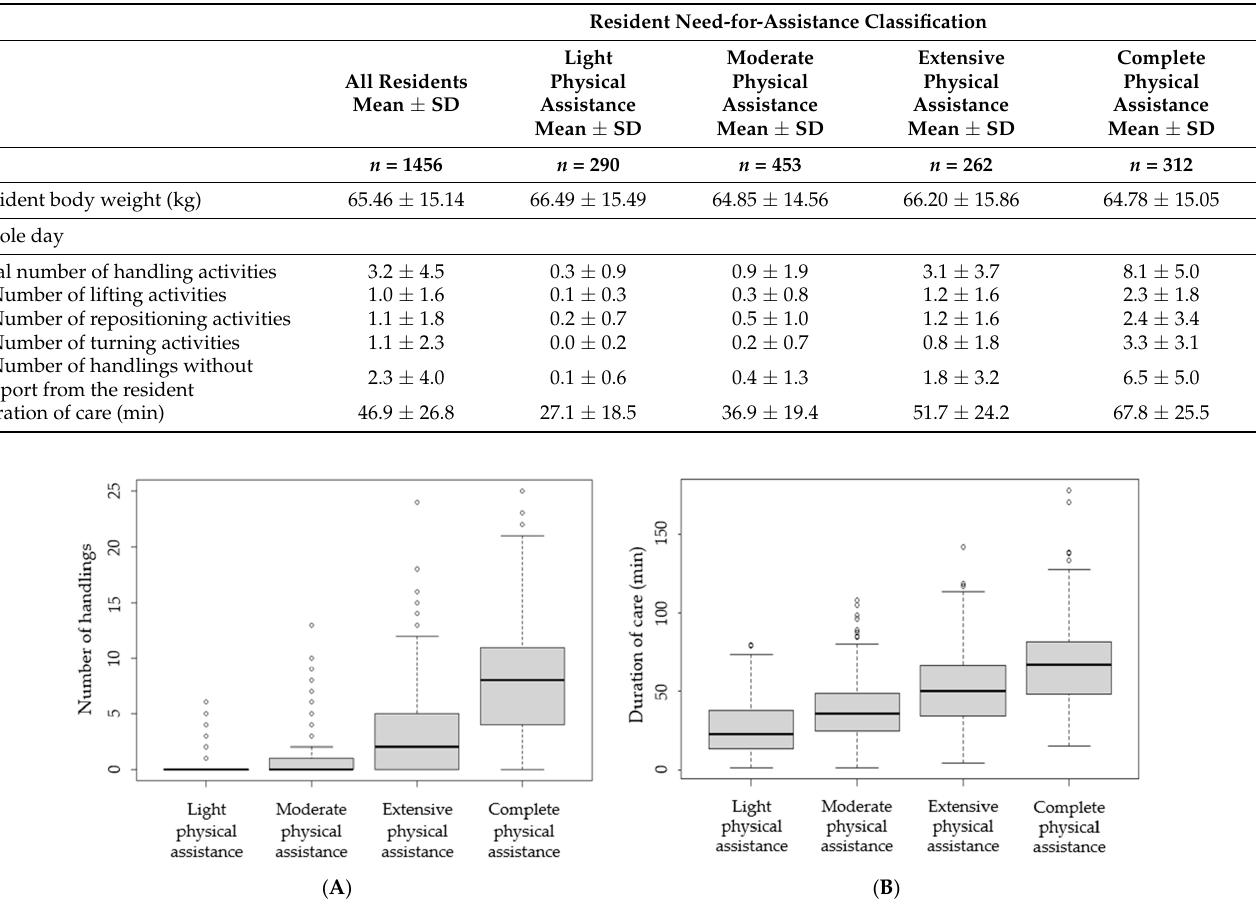
Figure 2. Boxplots for ( A ) total number of observed resident handlings (the total number of physical caring activities such as lifting, turning and repositioning the resident) and ( B ) observed duration of care (the total time spend caring for the resident) on a whole day (day and evening shifts com- bined) according to the resident need-for-assistance scale. Table 1. Descriptive results of the residents’ observed need for physical assistance according to the resident need-for-physical-assistance scale.